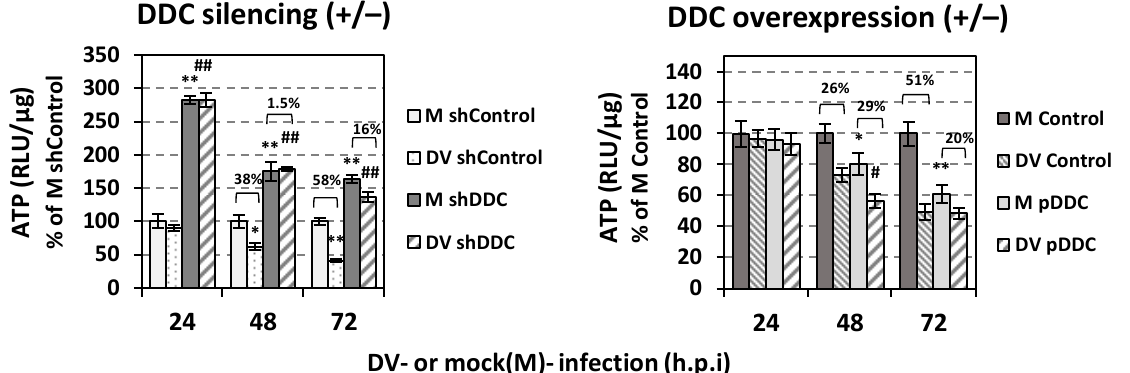
Figure 3. The expression levels of DDC affect the intracellular ATP of DV-infected cells. ( Left panel ) DDC silencing increases the intracellular ATP levels of DV-infected cells. Huh7 cells were transfected with shDDC vector or the control vector (shControl), (via electroporation) 24 h.p.t. were inoculated with non-reporter DV (MOI = 1) virus or were mock-infected (mock, M) for 4 h and then cultured for the pointed hours post-infection (h.p.i). shControl-expressing mock-infected cell (M shControl) values were set as 100%. The mean values ± standard deviations from three independent experiments in triplicate are featured. Percentages of ATP reduction are shown above brackets. * p < 0.01, ** p < 0.001 vs. M shControl, ## p < 0.001 vs. DV shControl. ( Right panel ) DDC overexpression reduces the intracellular ATP levels of DV-infected cells. Twenty-four hours after transfection of Huh7 cells with pcDNA3.1-DDC (pDDC) (+) or the control vector (Control) ( − ), cells were infected with non- reporter DV (MOI = 1) virus or mock-infected (mock, M) for 4 h and cells were lysed at the indicated h p.i. By the use of a chemiluminescence-based assay the intracellular ATP was quantified and calculated as RLU/ µ g of total protein amount. Values from cells transfected with the control vector and mock-infected (M Control) were set as 100%. * p < 0.01, ** p < 0.001 vs. M Control, # p < 0.01 vs. DV